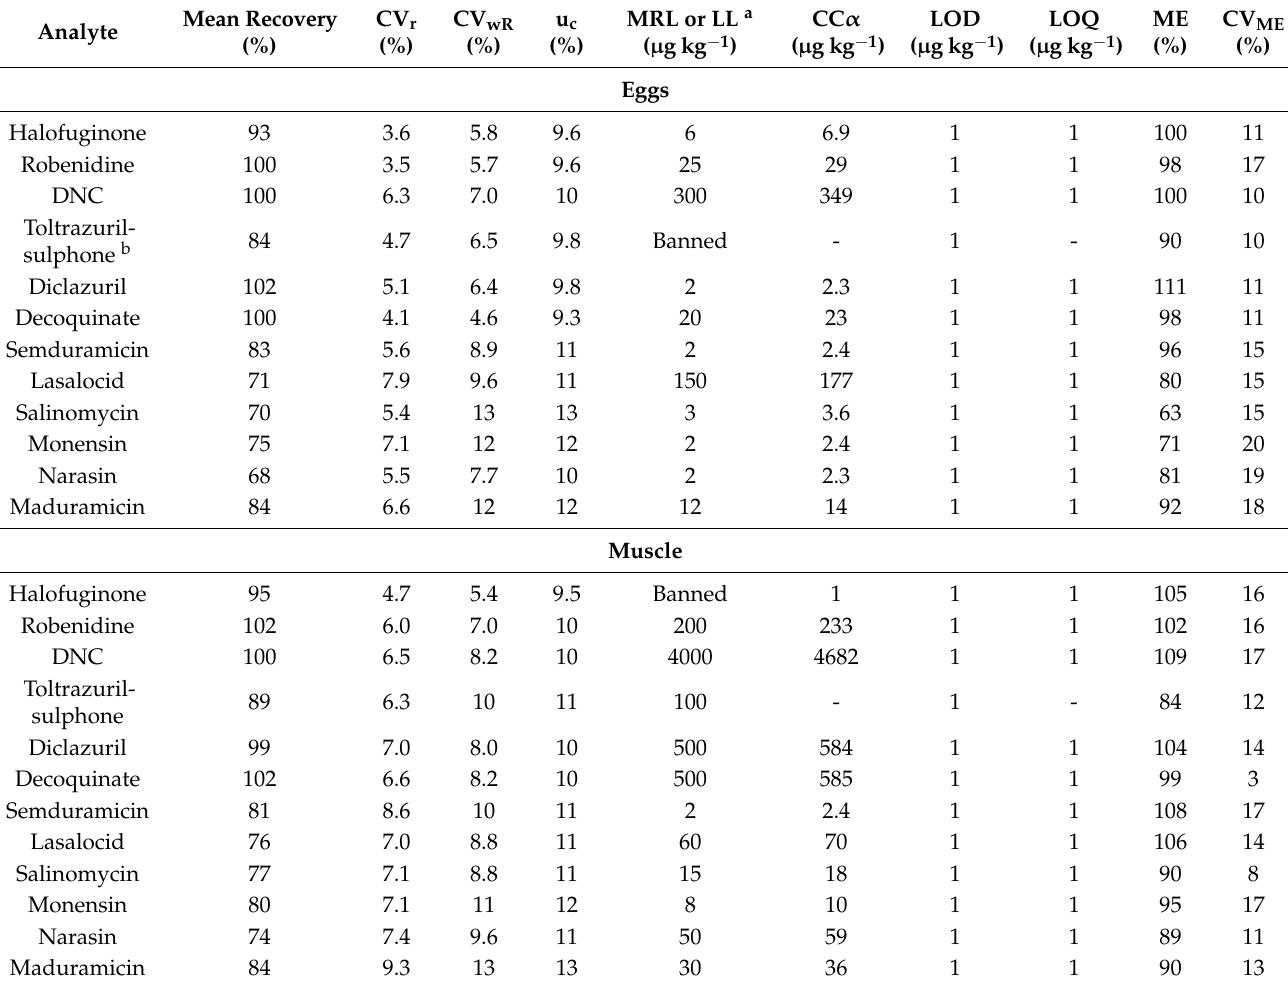
Table 4. Validation performances of the analytes for poultry eggs and muscle sorted by elution